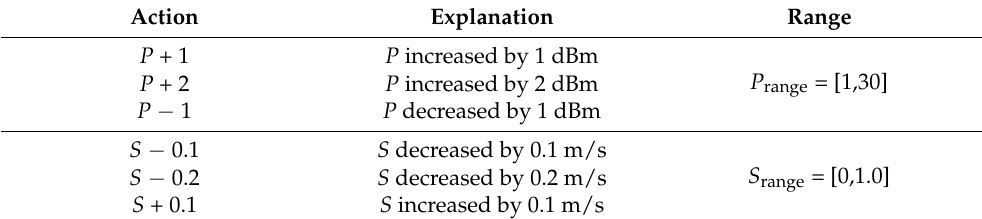
Table 6. Action space δ .